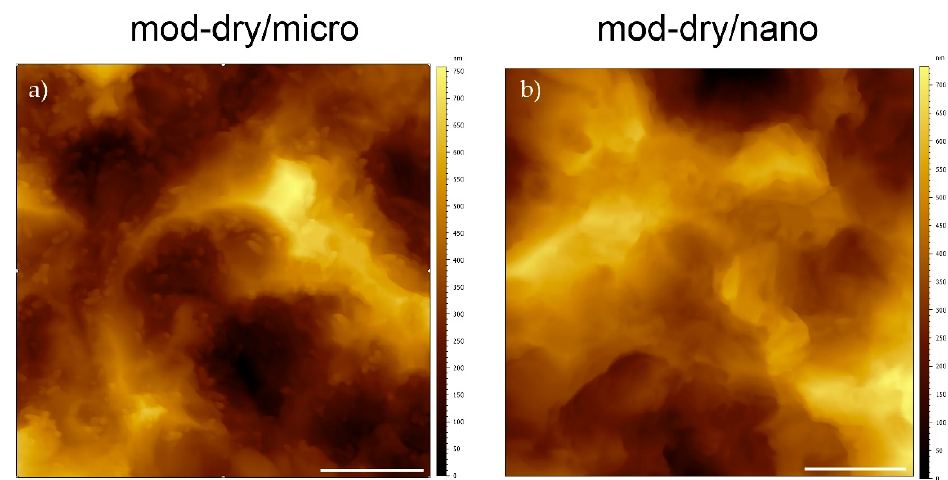
Figure 2. AFM topography images of nano ‐ structured ( a ) and micro ‐ structured ( b )